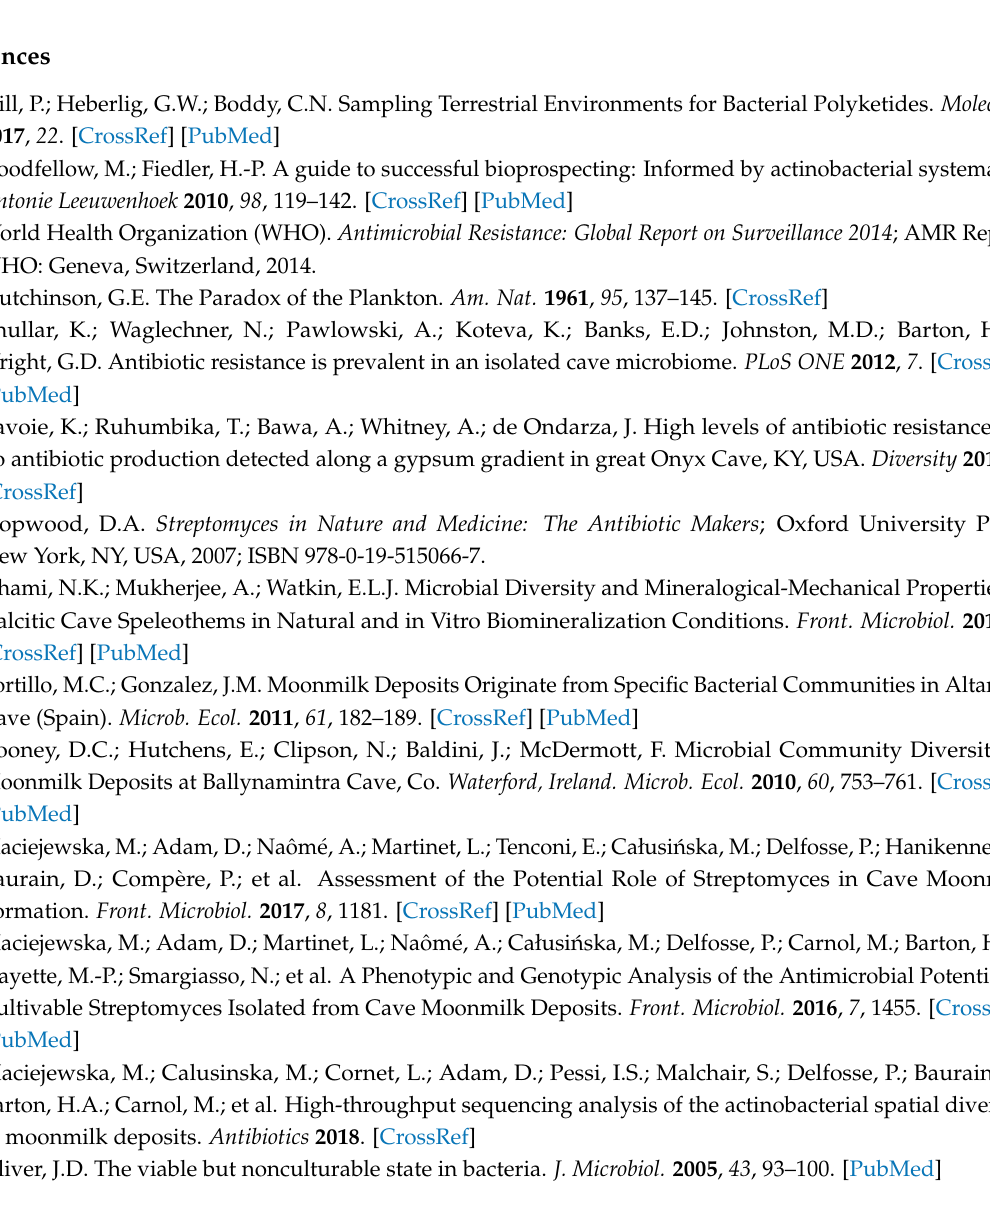
Figure S1: Phylogenetic tree of newly isolated moonmilk-dwelling Actinobacteria strains based on the V6–V7 region of the 16S (SSU) rRNA gene; Figure S2: Closest OTUs (V6–V7 regions) for the 40 MMun strains; Table S1: OTUs and their abundance in moonmilk deposits of the “Grotte des Collemboles”; Table S2: Accession number of 16S rRNA sequences of MMun strains. Please provide the Table S2 that can be edited and put Figure S1 and Tables S1 and S2 into Word